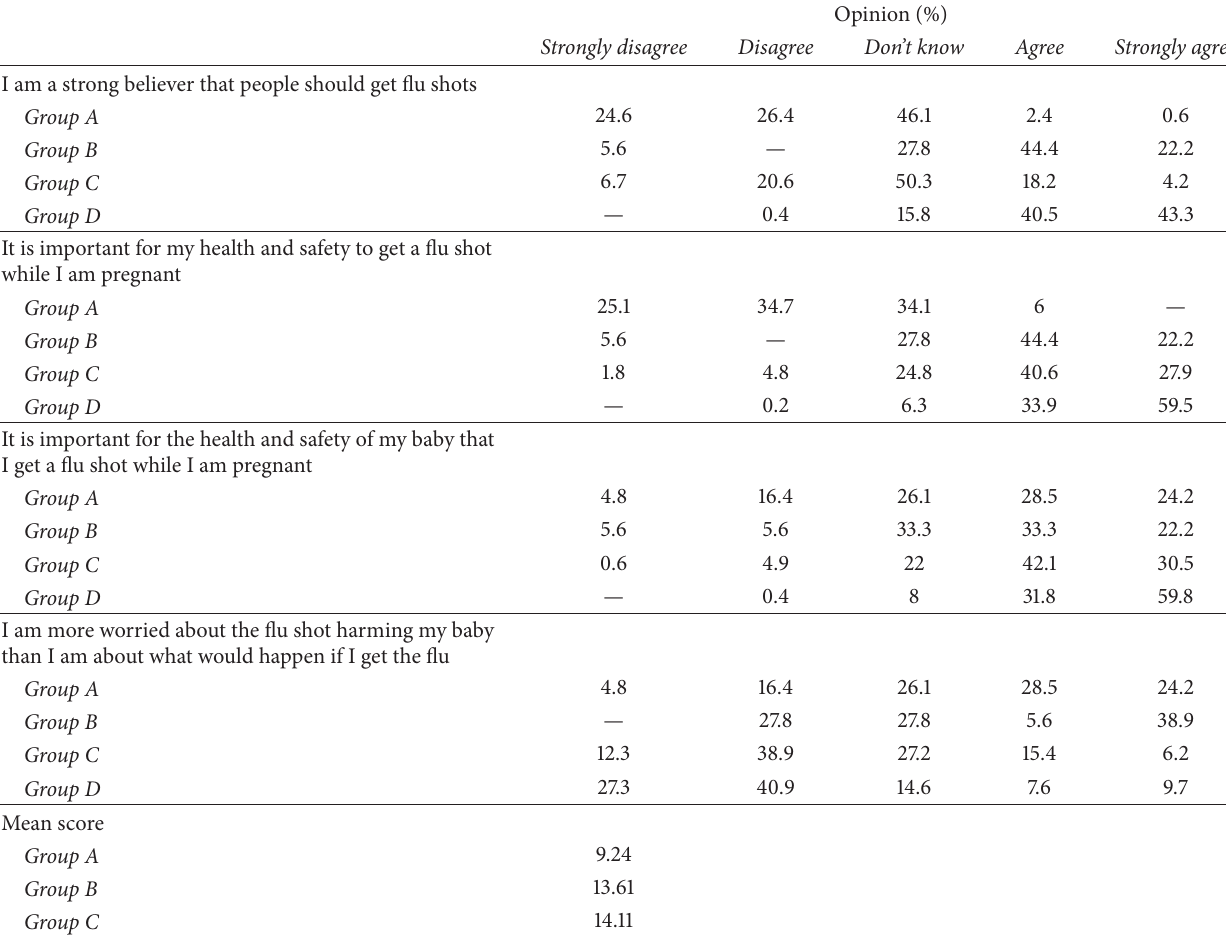
Table 5: Patient flu vaccine practices and